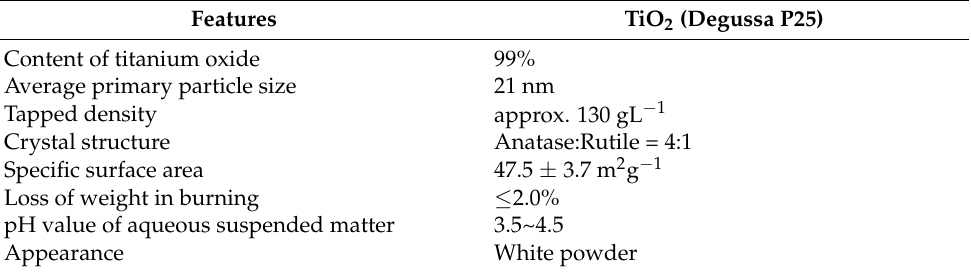
Table 1. Physical and chemical features of commercial P25-TiO 2 .